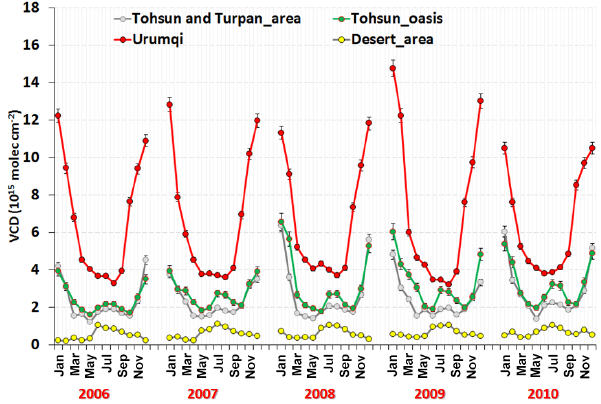
Figure 10. Monthly mean tropospheric NO 2 VCD during 2006– 2010 over selected areas (unit: 10 15 moleculescm − 2 )